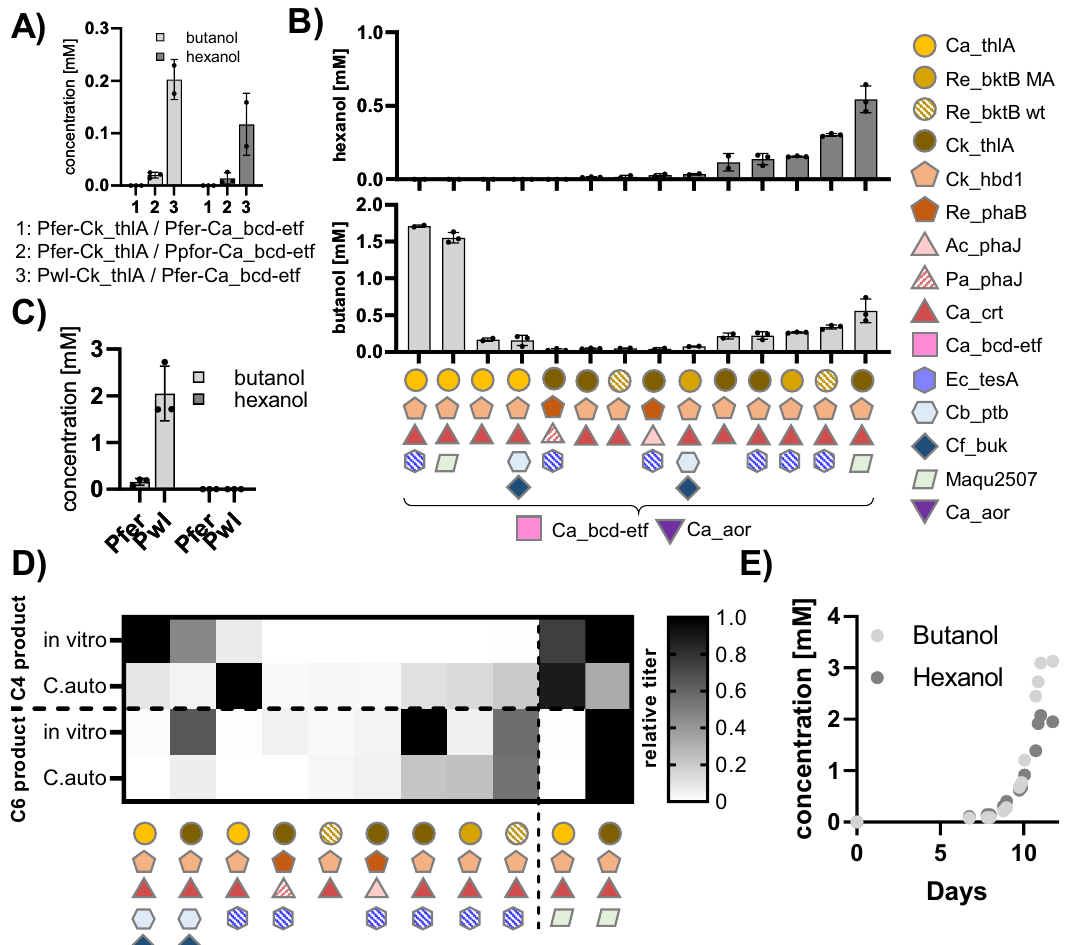
Fig. 5 Implementation of r-BOX into the non-model organism C. autoethanogenum . A Initial promoter optimization to de fi ne architecture for the screen. B Testing 14 different r-BOX variants in C. autoethanogenum for butanol and hexanol production. For detailed strain architecture see attached sheet Figure5_Cauto. C Promoter optimization for C. autoethanogenum strain containing Ca_thlA, Ck_hbd1, Ca_crt, Ca_bcd-etf, Cb_ptb, Cf_buk. D Normalized titers for C4 and C6 products in vitro and in C. autoethanogenum . In vitro data was normalized to the highest producing condition observed in Fig. 2 for either acid (in case of thoesterase or ptb-buk termination) or alcohol (in case of ACR-ADH termination). C. autoethanogenum titers were normalized to the highest alcohol producing strain for either butanol or hexanol. Data represent at least n = 3 independent experiments, with the standard deviation and mean shown. Detailed results and full information on enzyme abbreviations in Source Data fi le. E Continuous 1.5 L fermentation of C. autoethanogenum strain containing Ck_thlA, Ck_hbd1, Ca_crt, Ca_bcd-etf,